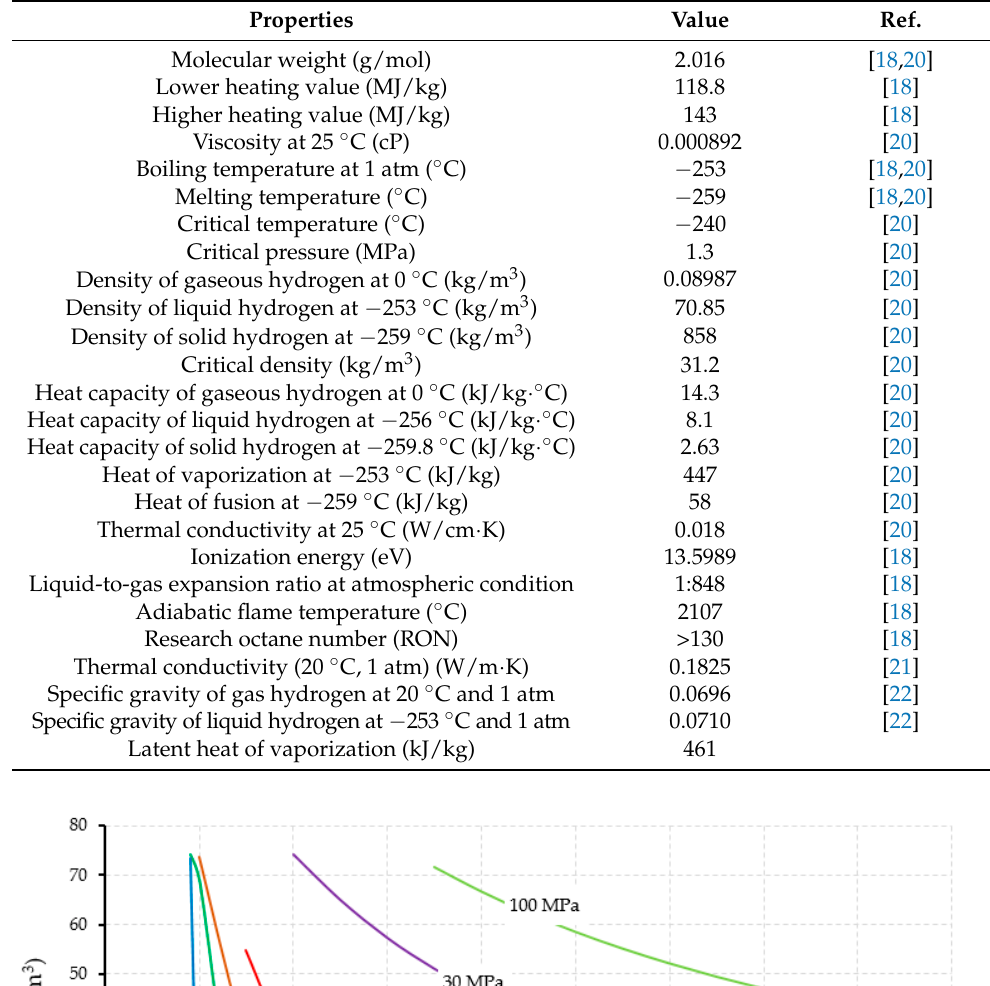
Table 1. Physical properties of hydrogen.